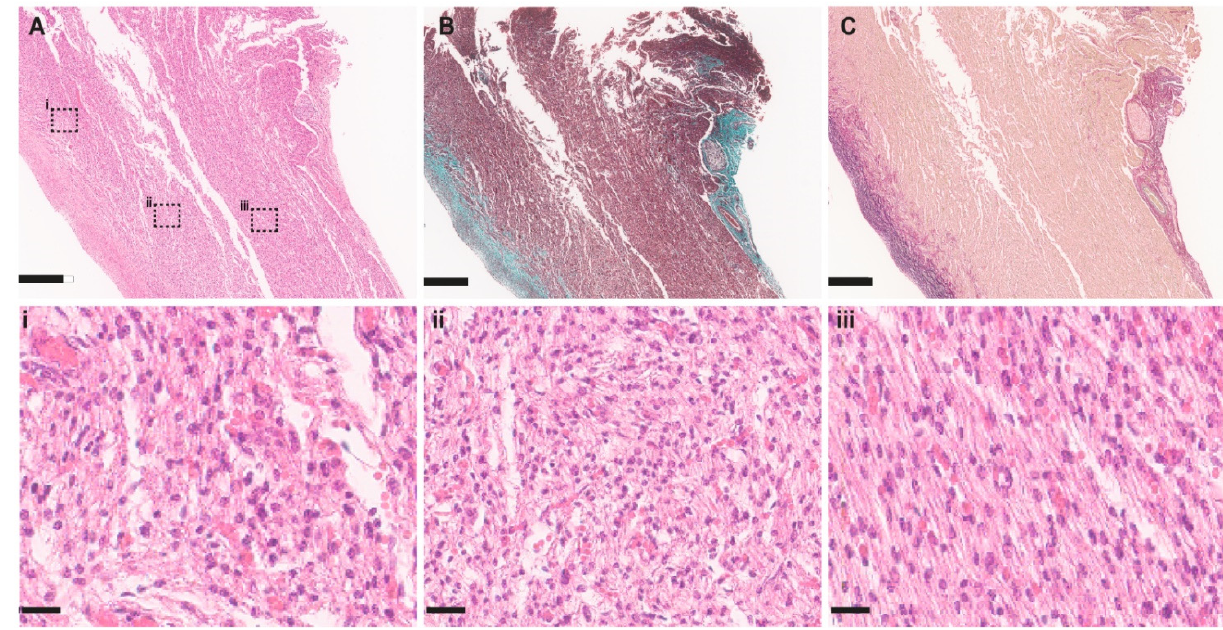
Figure 2. Histological appearances of HLHS heart with peach-like ventricular phenotype (MS/AS and EFE). ( A – C ) Sections through free wall of left ventricle. ( A ) H&E stain of left ventricular free wall. ( i ) High powered views of the myocardium show marked cardiomyocyte disarray and vacu- olated cardiomyocytes in areas close to the endothelial surface. ( ii ) Further way from the lumen there is evidence of myocardial disarray, but the vacuolated cardiomyocyte appearances are less prominent. ( iii ) The epicardial side the myocardium appears ordered and the cardiomyocytes grossly normal. ( B ) Masson’s trichrome stain showing collagen deposits (blue) in the sub-luminal myocardial wall. This affects the areas of myocardium with most cardiomyocyte disarray. ( i ) Mil- lers’ elastin stain shows prominent elastin fibre deposition black staining) in luminal part of the left ventricular myocardium. Scale bar in ( A – C ) = 500 um, in ( i – iii ) = 200 um.